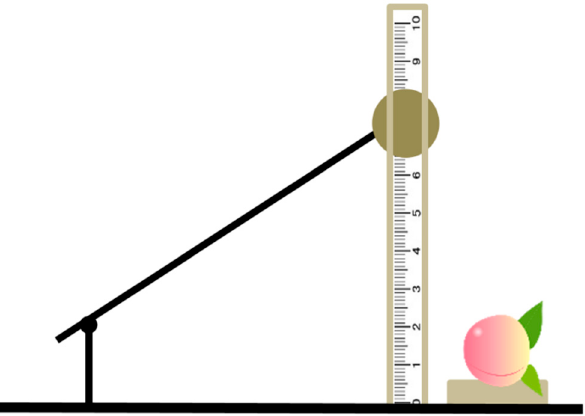
Figure 1. A wooden-ball pendulum impacting device for bruised test on peaches.